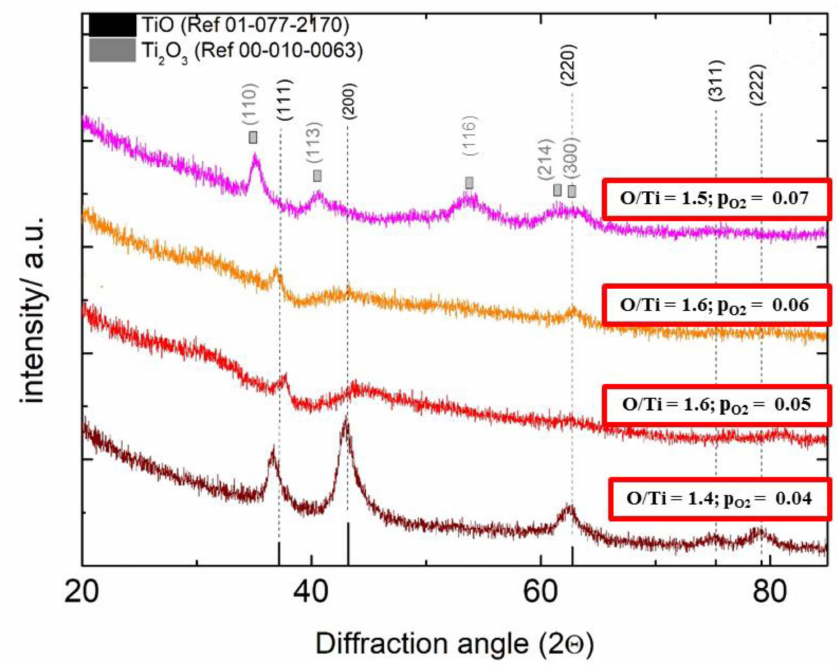
Figure 5. GIXRD patterns for samples of G1 deposited on silicon substrates. TiO and Ti 2 O 3 reference peaks are included in the graph.